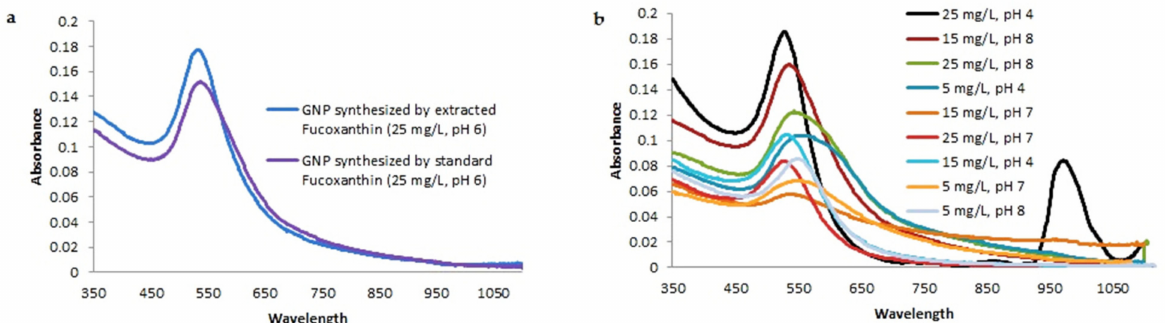
Figure 4. UV-vis spectroscopy of GNP synthesized by extracted fucoxanthin from N. shiloi and standard fucoxanthin ( a ). UV-vis spectroscopy of GNP synthesized by the whole biomass of N. shiloi using different concentrations and pH of HAuCl 4 solutions ( b ).